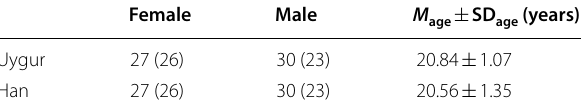
The number in the bracket was the number after exclusion. Participants whose reaction time or error rate above the average of this group by 3 standard deviations were excluded. Correspondingly, participants who matched gender and age were excluded from the other group. Table 3 is the